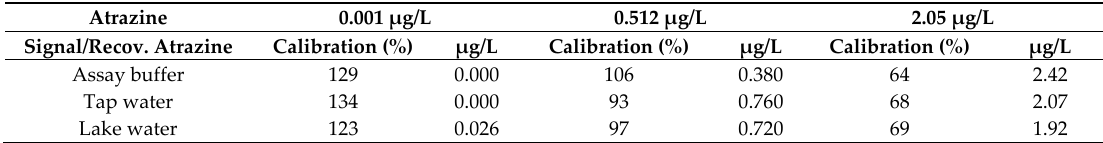
Table 1. Matrix effects on atrazine